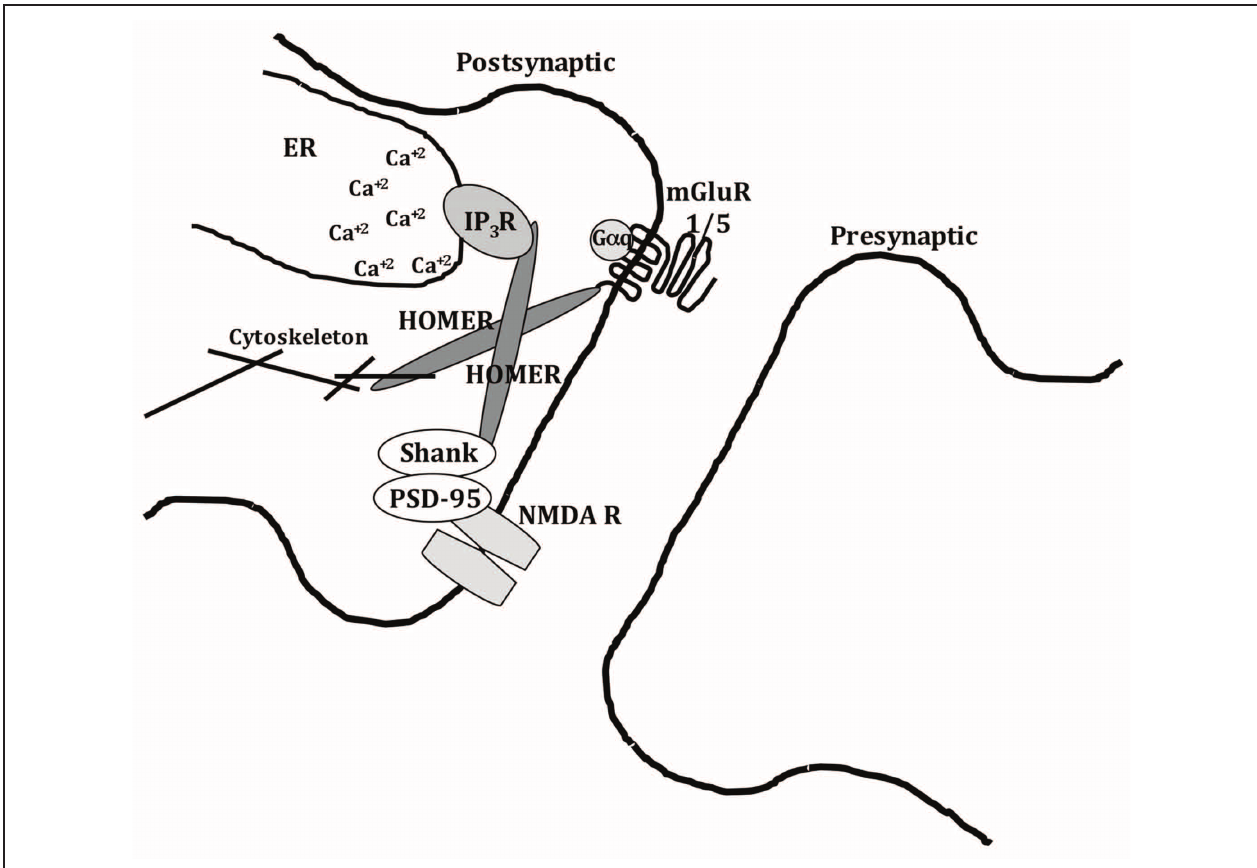
FIGURE 1 | Homer protein scaffolding at post-synaptic synapses. The Homer scaffolding complex links mGluR1/5 receptors to intracellular calcium stores via IP 3 receptors, and also links to NMDA receptors to dynamically regulate the transfer of somatosensory